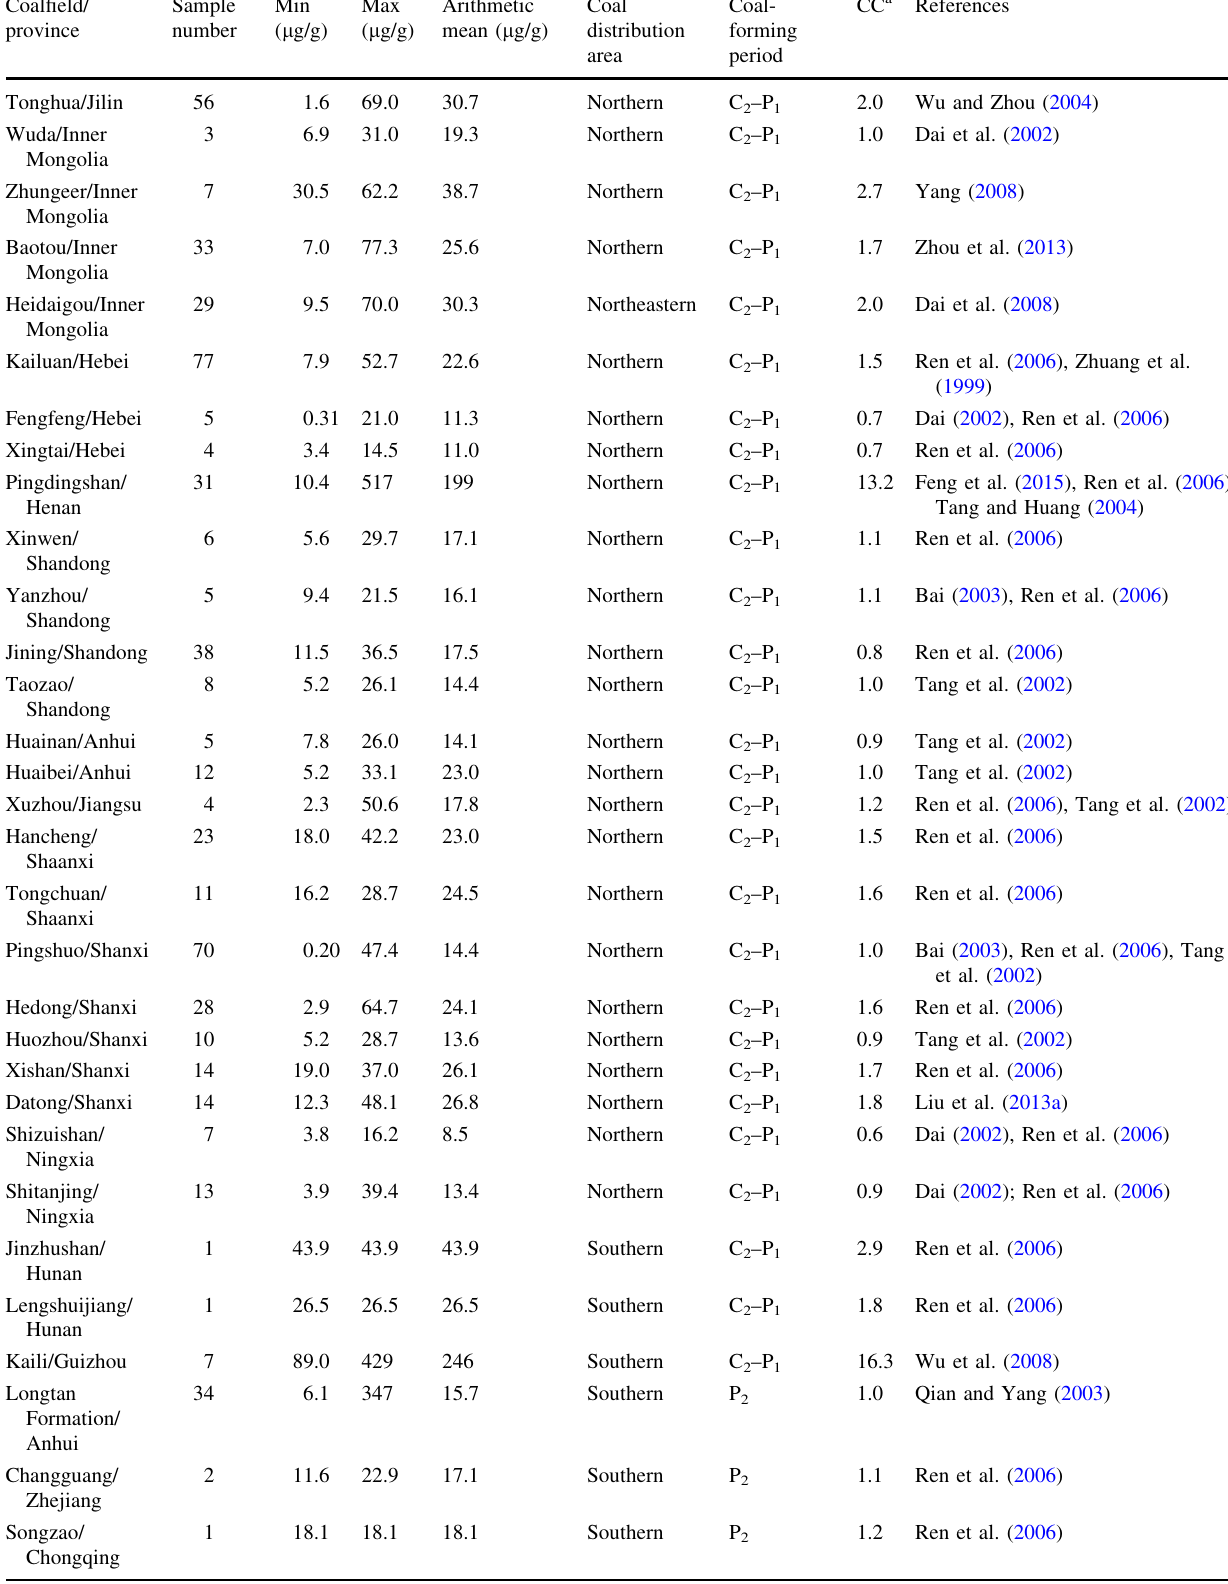
Table 2 Lead concentrations in Chinese